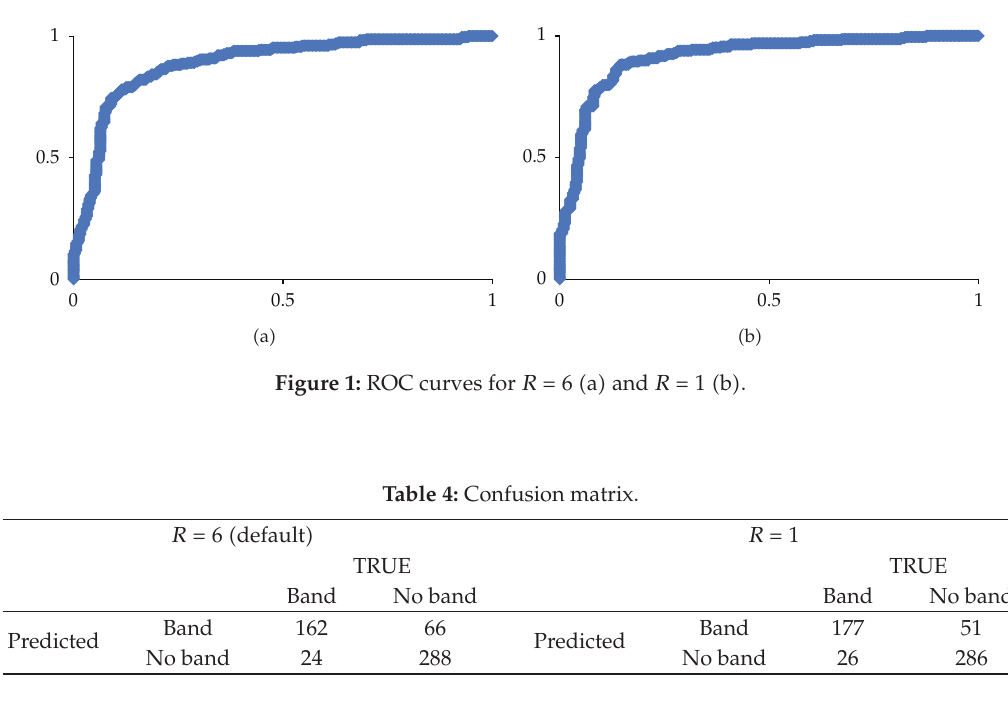
Table 5: Comparison of accuracy in other data mining methods.